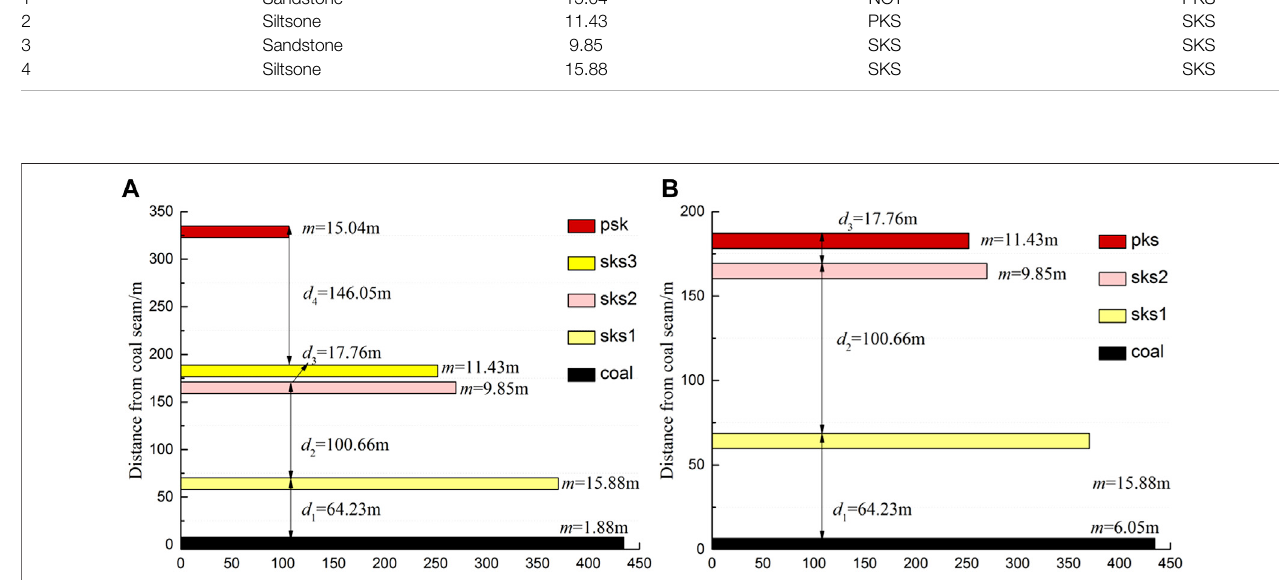
FIGURE 10 | Program calculation results and actual situation. (A) The results of the program calculation. (B) The actual situation of the Xiadian coal mine.